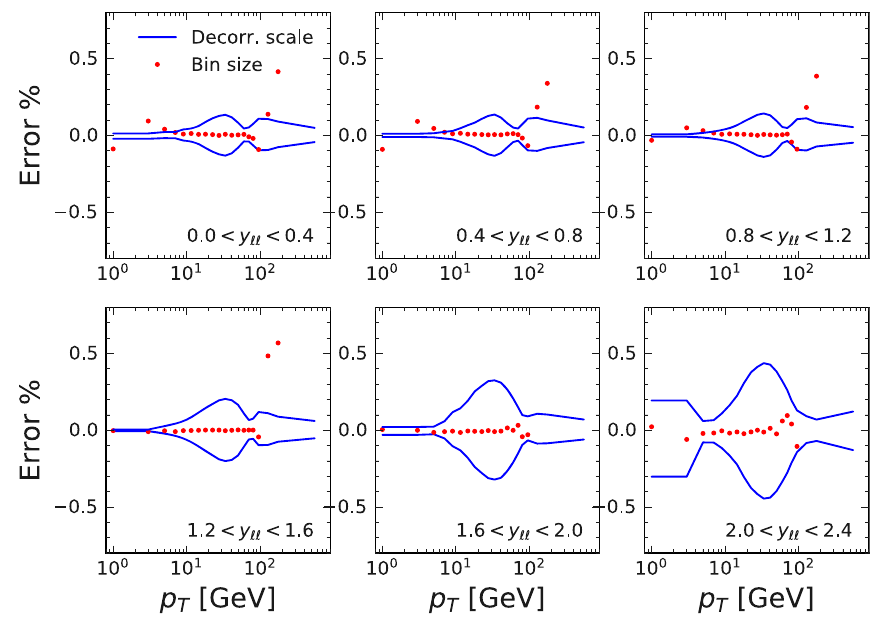
Fig. 5 Bin size and QCD scale uncertainties calculated assuming independent variations of q ¯ q and qg